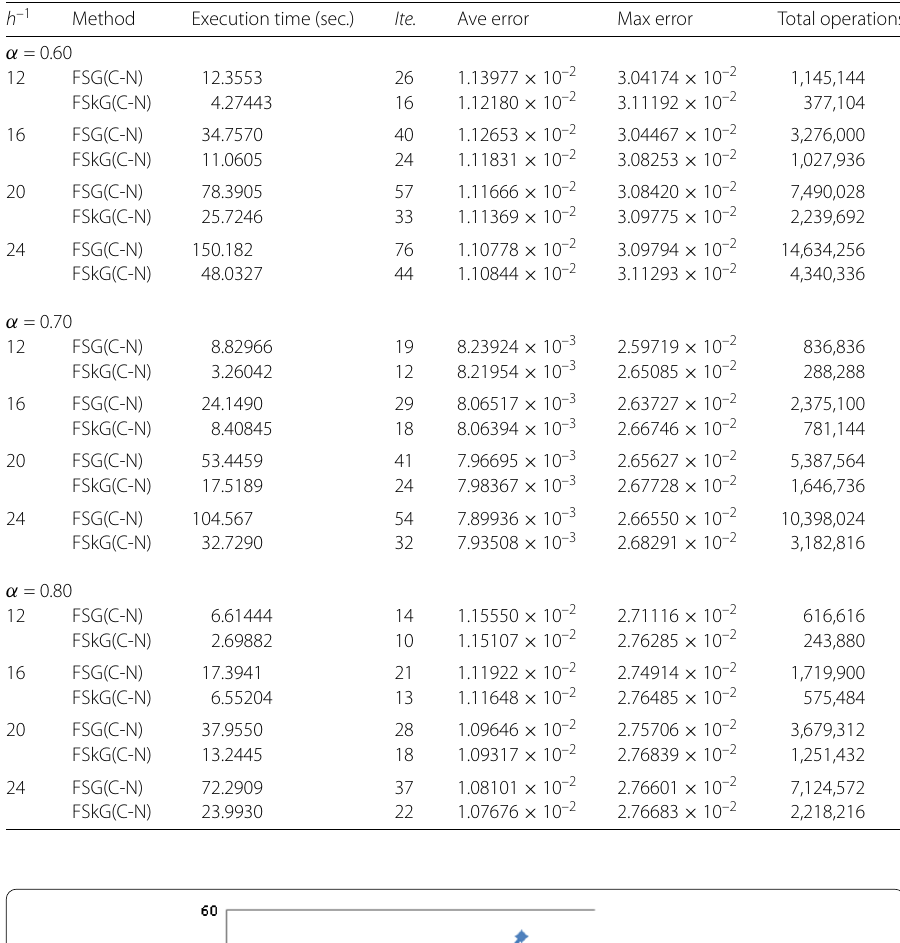
Table 5 Comparison between FSG(C-N) and FSkG(C-N) iterative methods τ = 1/15 for Example 2